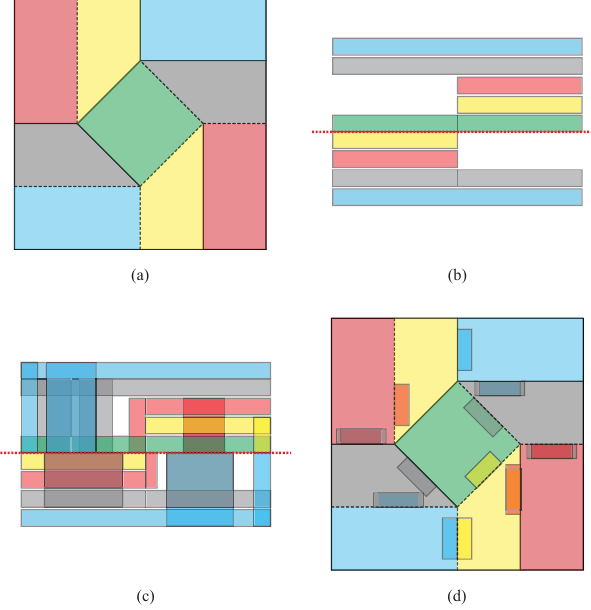
Figure 12. A schematic of the pattern used in the design of the toolbox. (a) The crease pattern. (b) The stacked panels and the joint plane (in red). (c) The stacked panels with added offsets. (d) The unfolded pattern including the offsets.